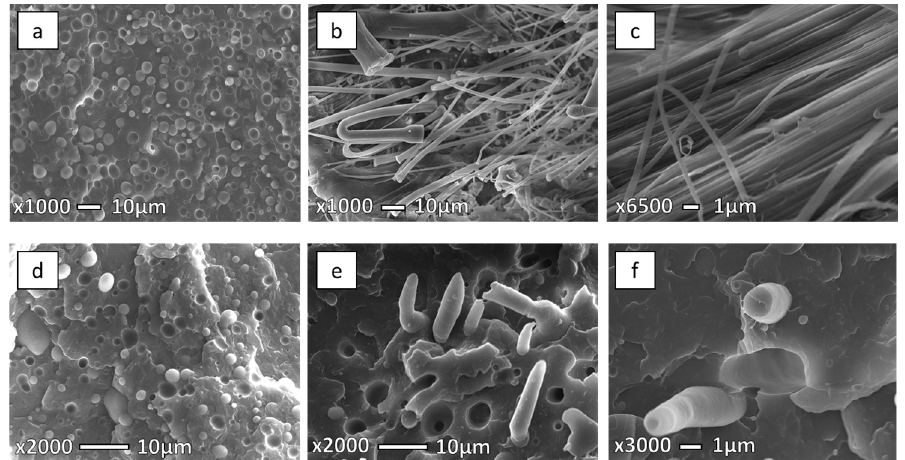
Figure 5. SEM micrographs of freeze-fracture surfaces under liquid nitrogen of the 70PP/30PET ( a ) extrusion blend; ( b , c ) stretched blend; ( d ) IMB at 210 °C; ( e , f ) MFC at 210 °C.